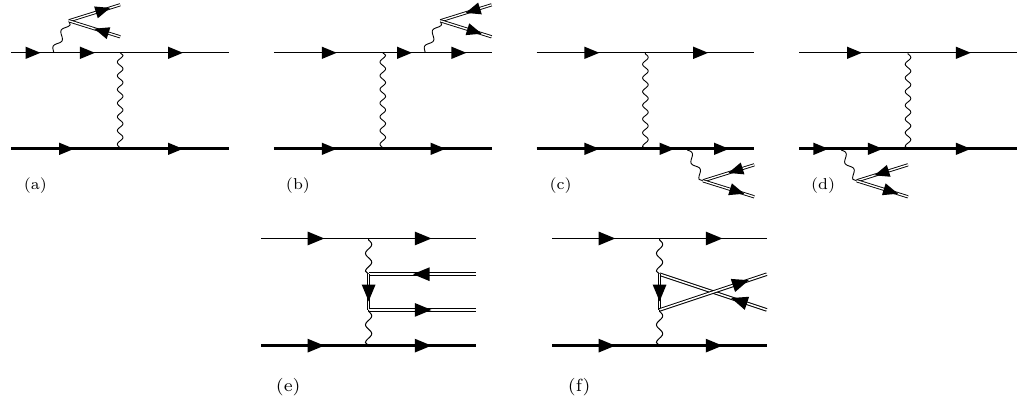
Figure 8. Lepton-pair real radiation diagrams. We do not display the diagrams obtained by exchanging the fermionic lines corresponding to the same